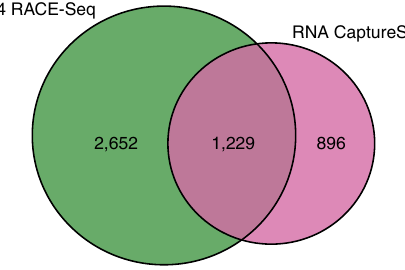
Figure 6 | RACE-Seq performance compared with CaptureSeq. Venn diagram indicating the number of annotated and unannotated on-target ( ± 5kb) splice junctions discovered by RNA CaptureSeq and RACE-seq. Only the top 25% splice junctions with canonical splice sites ranked by read coverage were included in this analysis (see